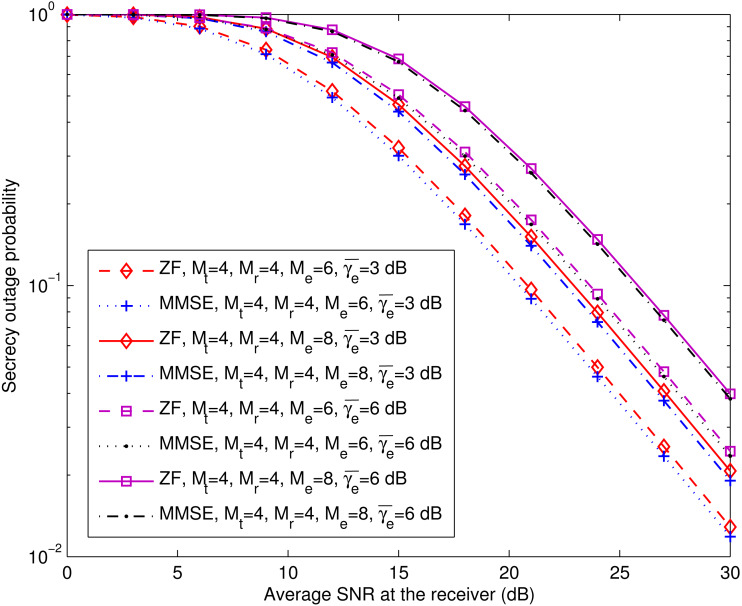
Pout,ZF versus Pout,MMSE for various Me at fixed Mt and Mr (Mt = Mr = 4).This figure shows the theoretical secrecy outage curves for the ZF equalization-based and MMSE equalization-based spatial multiplexing systems with different numbers of antennas and average SNRs at the eavesdropper (Me and \documentclass[12pt]{minimal}
\usepackage{amsmath}
\usepackage{wasysym}
\usepackage{amsfonts}
\usepackage{amssymb}
\usepackage{amsbsy}
\usepackage{upgreek}
\usepackage{mathrsfs}
\setlength{\oddsidemargin}{-69pt}
\begin{document}
}{}${\bar {\gamma }}_{\text{e}}$\end{document}γ ¯e), and fixed numbers of antennas at the transmitter (Mt) and the legitimate receiver (Mr).